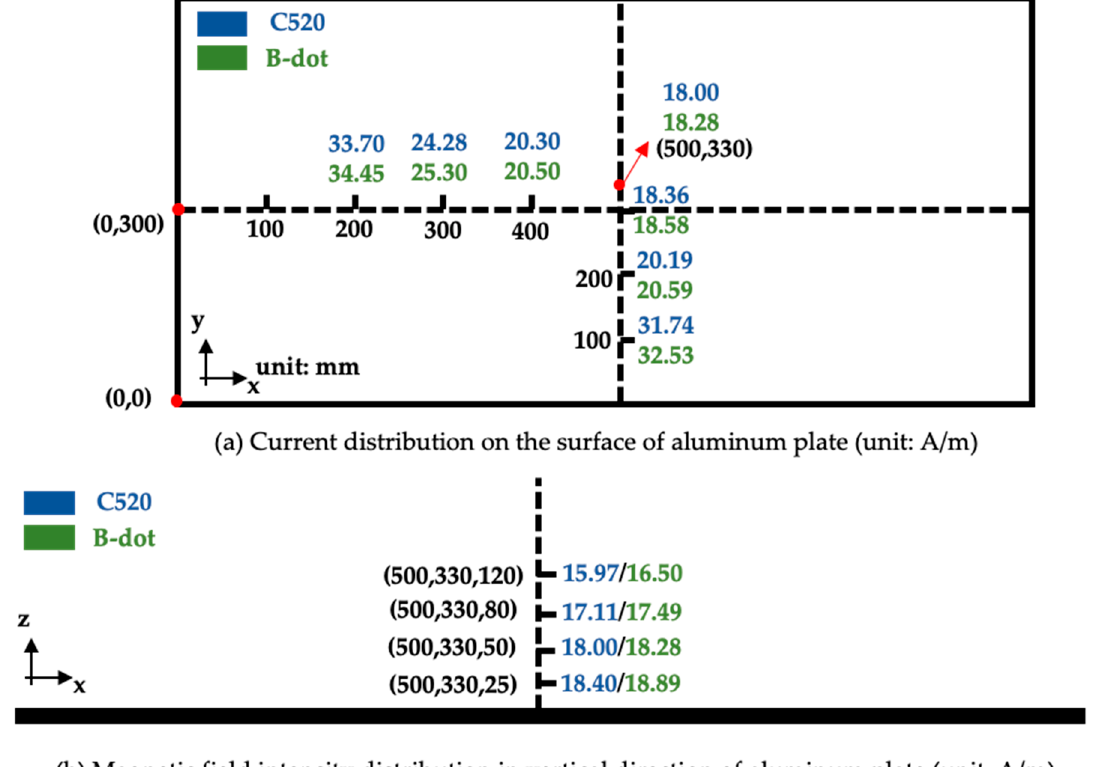
Figure 17. Comparison of C520 and B-dot in measuring the surface current distribution and magnetic field strength of the aluminum plate.